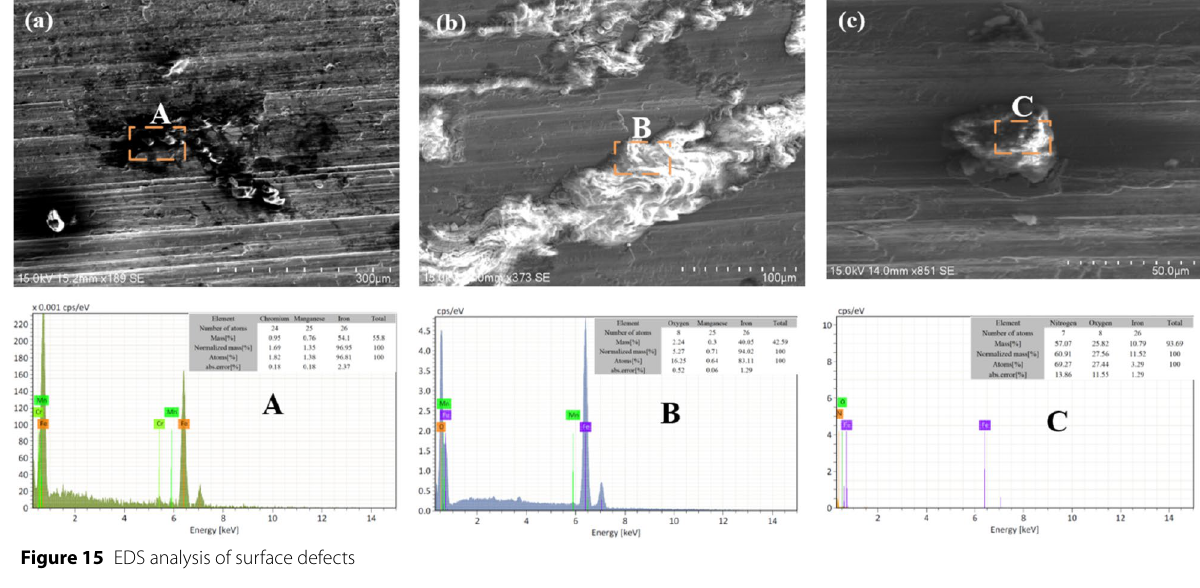
Figure 15 EDS analysis of surface defects